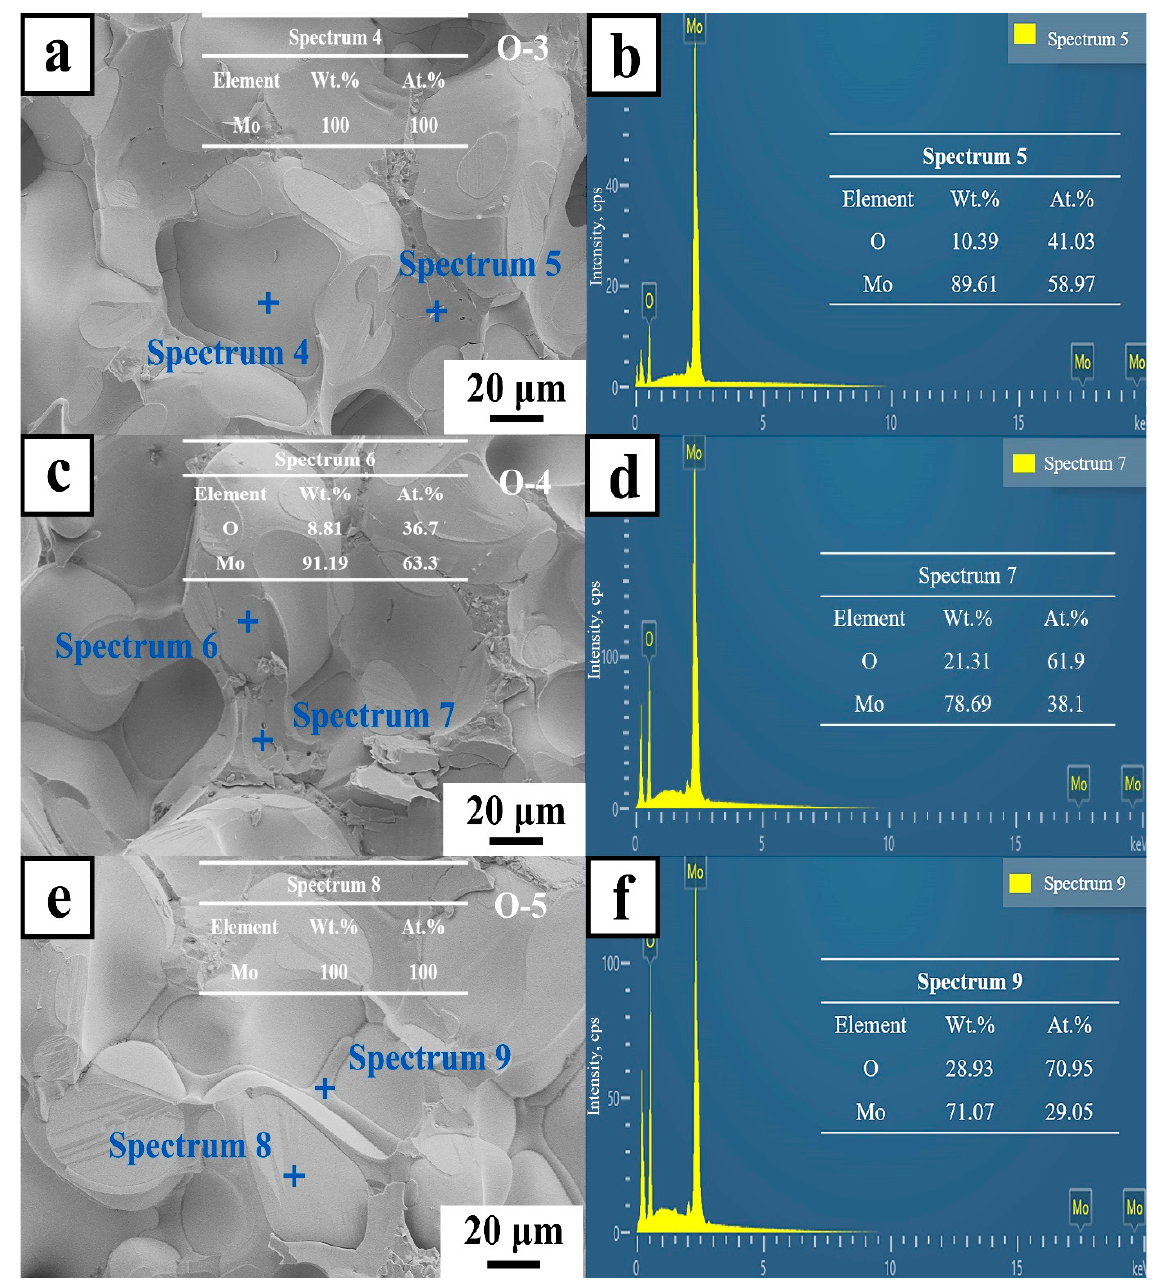
Figure 8. SEM images and EDS spectrum of O-3 to O-5 samples during preparation: ( a , b ) O-3 sample with 4700 wppm O; ( c , d ) O-4 sample with 6200 wppm O; ( e , f ) O-5 sample with 8600 wppm O.